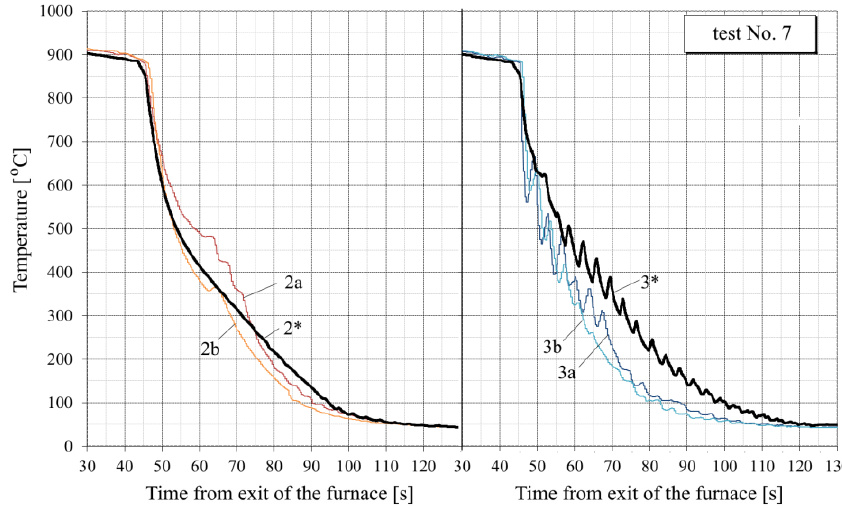
Figure A5. Graphs of cooling in test No. 7. The notations are the same as in Figure A4.